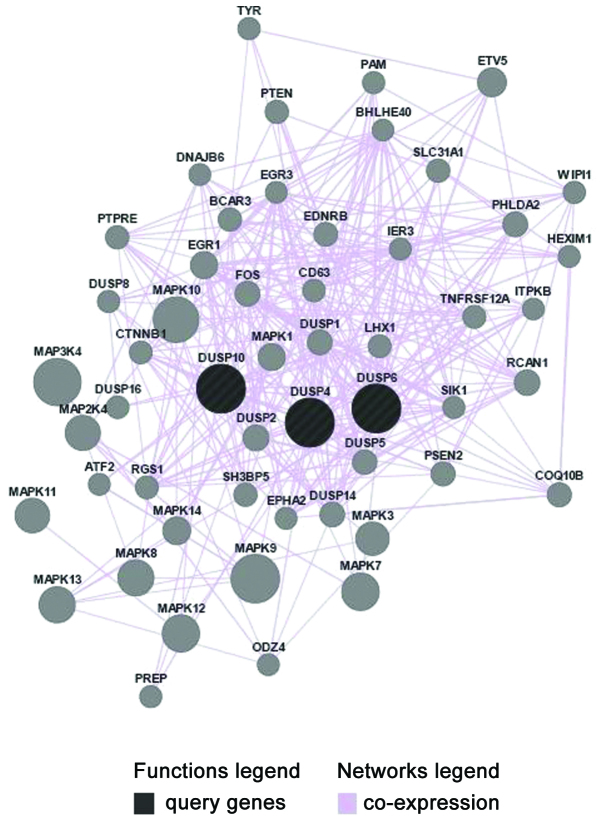
Co-expression network analysis from the GeneMania server using DUSP4, DUSP6 and DUSP10 as query genes.